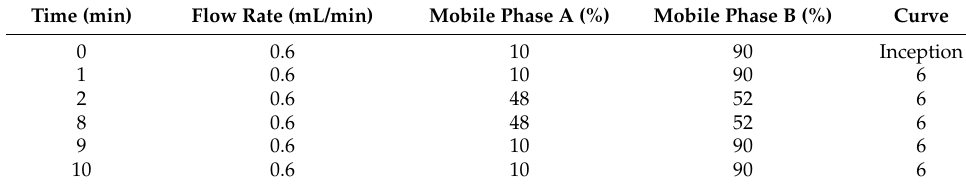
Table 1. Gradient elution program.